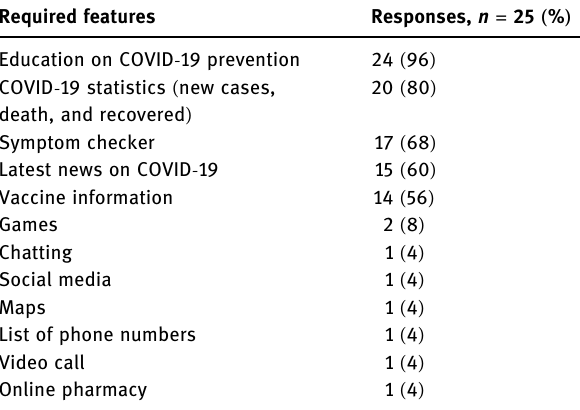
Required features